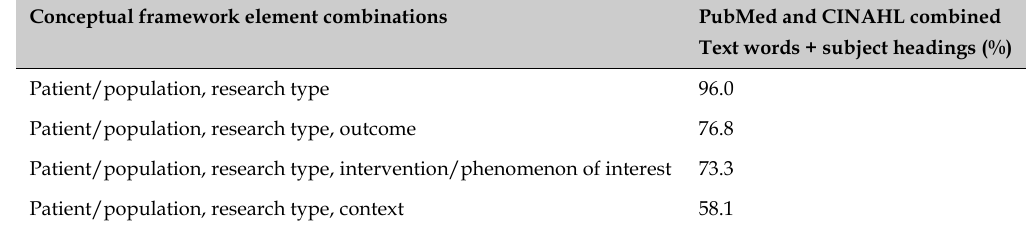
Table 3 Recall of combinations of conceptual framework elements using both text words and subject headings in PubMed and CINAHL